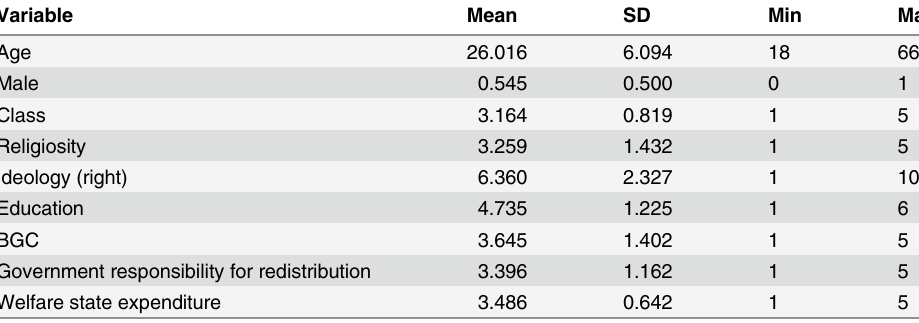
Table 1. Descriptive statistics, Israeli Jews sample (Study